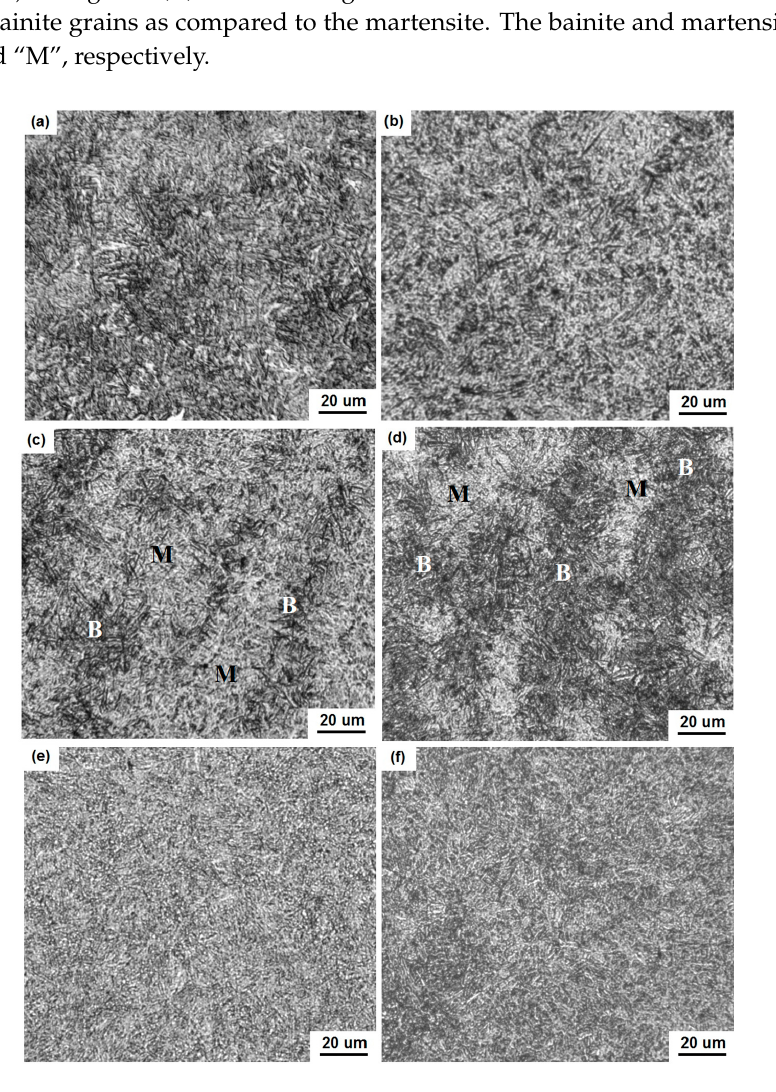
Figure 2. Optical micrographs of samples after 270 °C austempering treatment for various durations: ( a ) oil-quenched; ( b ) 5 min; ( c ) 10 min; ( d ) 20 min; ( e ) 40 min; and ( f ) 80 min.